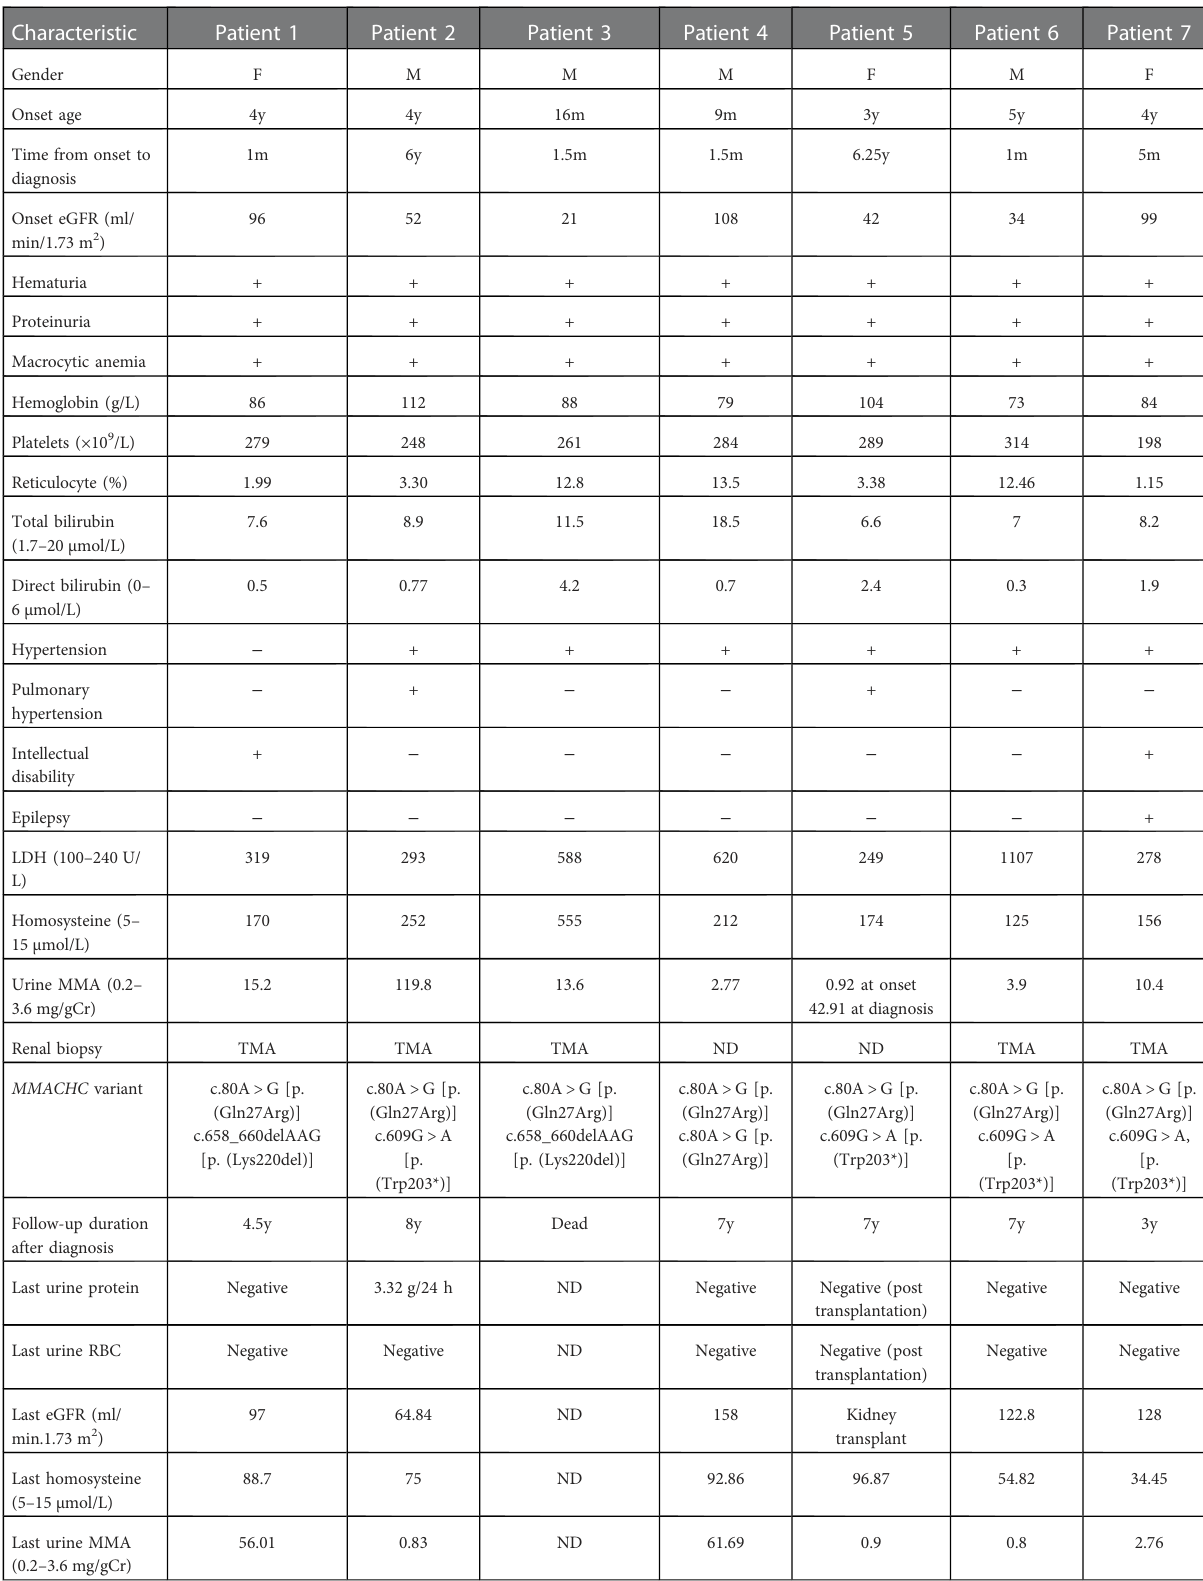
TABLE 1 Clinical and biochemical characteristics of the seven patients with cblC de fi